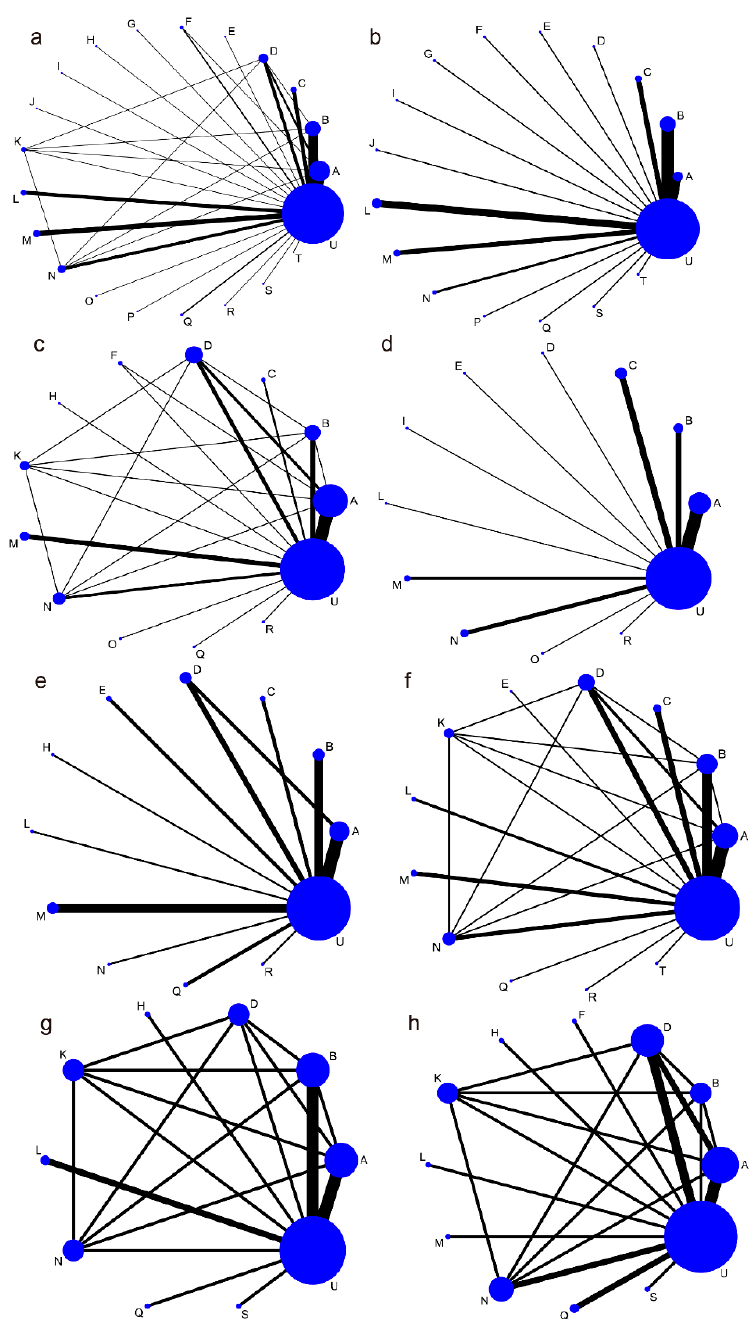
Figure 2. Networks of treatment comparisons. A, S. boulardii; B, LGG; C: L. reuteri; D, Bacillus clausii; E, L. acidophilus; F, B. lactis; G, L. sporogenes; H, L. plantarum; I, ECN 1917; J, L. paracasei; K, E. faecium; L, L. spp; M, L. spp + B. spp; N, L. spp + B. spp+ S. spp; O, L. spp + S. spp; P, B. spp + S. spp; Q, Bacillus spp + E. spp + C. spp; R, L. spp + B. spp + E. spp; S, L. spp + B. spp + P. spp; T, L. spp + S. spp + C. spp + Bacillus spp; U, control (placebo/no treatment). ( a ) network of the duration of diarrhea (control = placebo/no treatment); ( b ) network of the duration of diarrhea (control = placebo); ( c ) network of the duration of diarrhea (control = no treatment); ( d ) network for diarrhea lasting ≥ 2 days; ( e ) network of the duration of hospitalization; ( f ) network of the mean stool frequency on day 2; ( g ) network for the duration of vomiting; ( h ) network of the duration of fever. The circle size indicates the number of patients, and the line thickness indicates the number of trials .